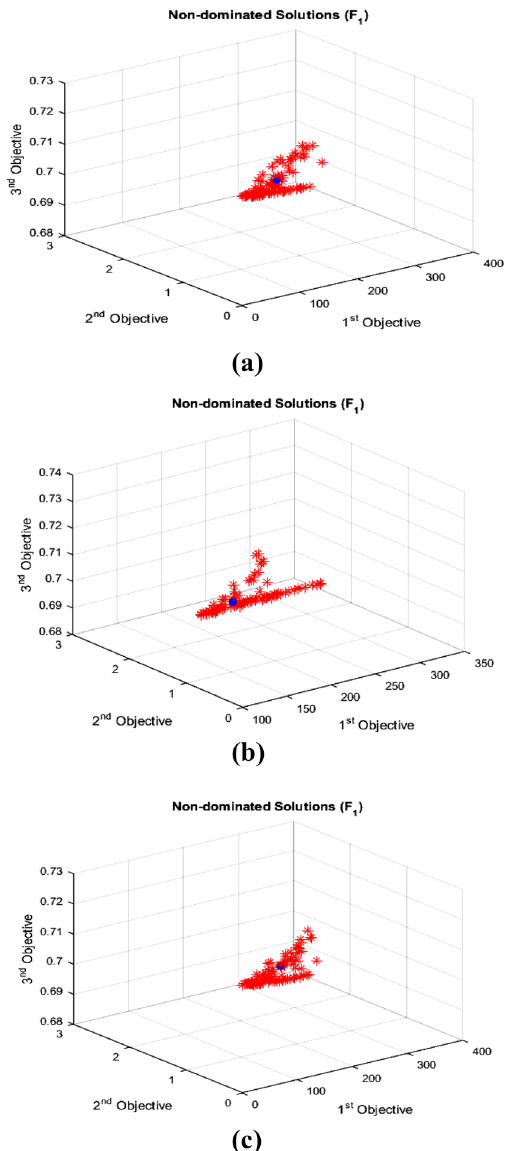
Fig. 9 The graph of the value target functions in the 69-bus network, a unit, b 0.85 Post-phase, c 0.85 pre-phase